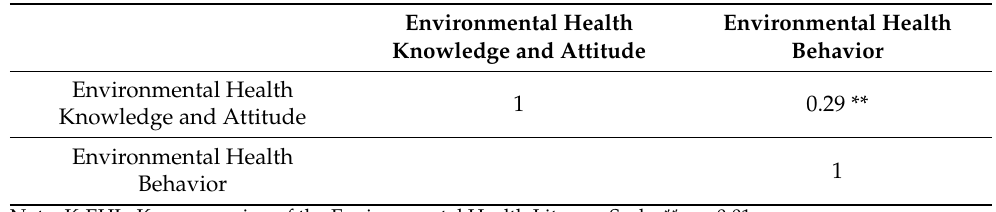
Table 4. Correlation matrix by factor of the Korean version of the Environmental Health Literacy (K-EHL) Scale.